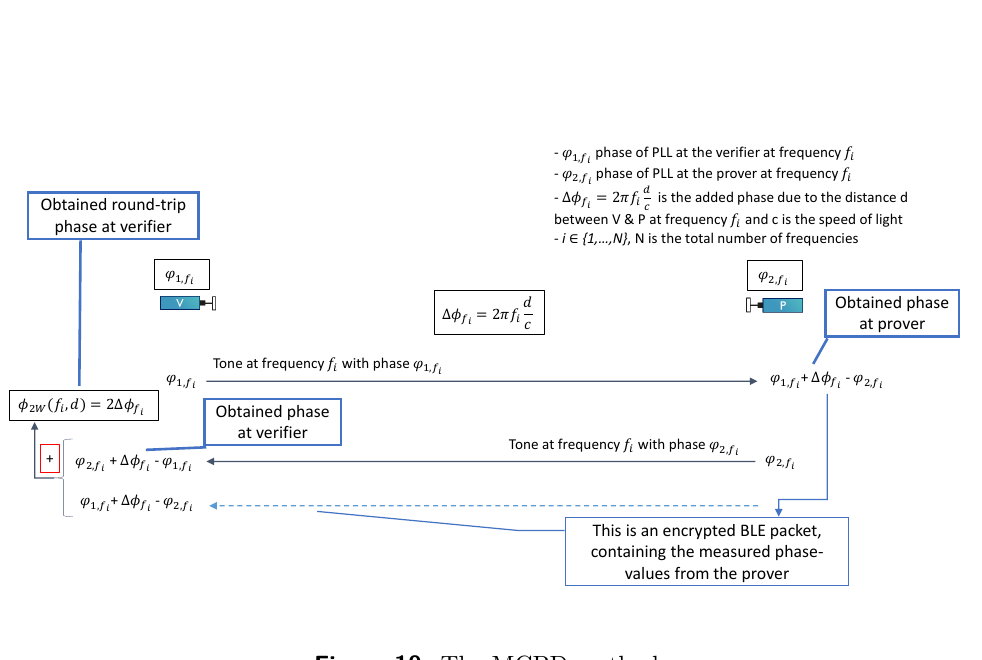
Figure 10: The MCPD